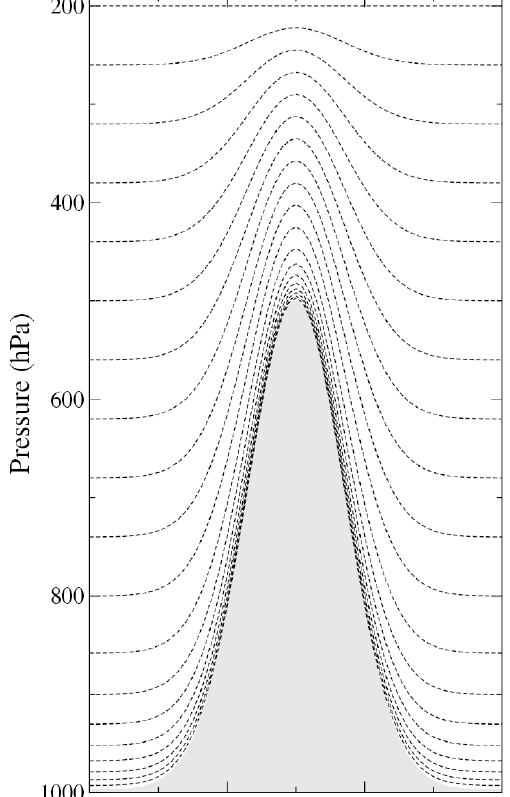
Figure 4. Model pressure levels with 20 vertical levels: thickness of the first model layer is 3hPa, top of model set at 200hPa. Pressure levels are represented across an idealized mountain with a top at